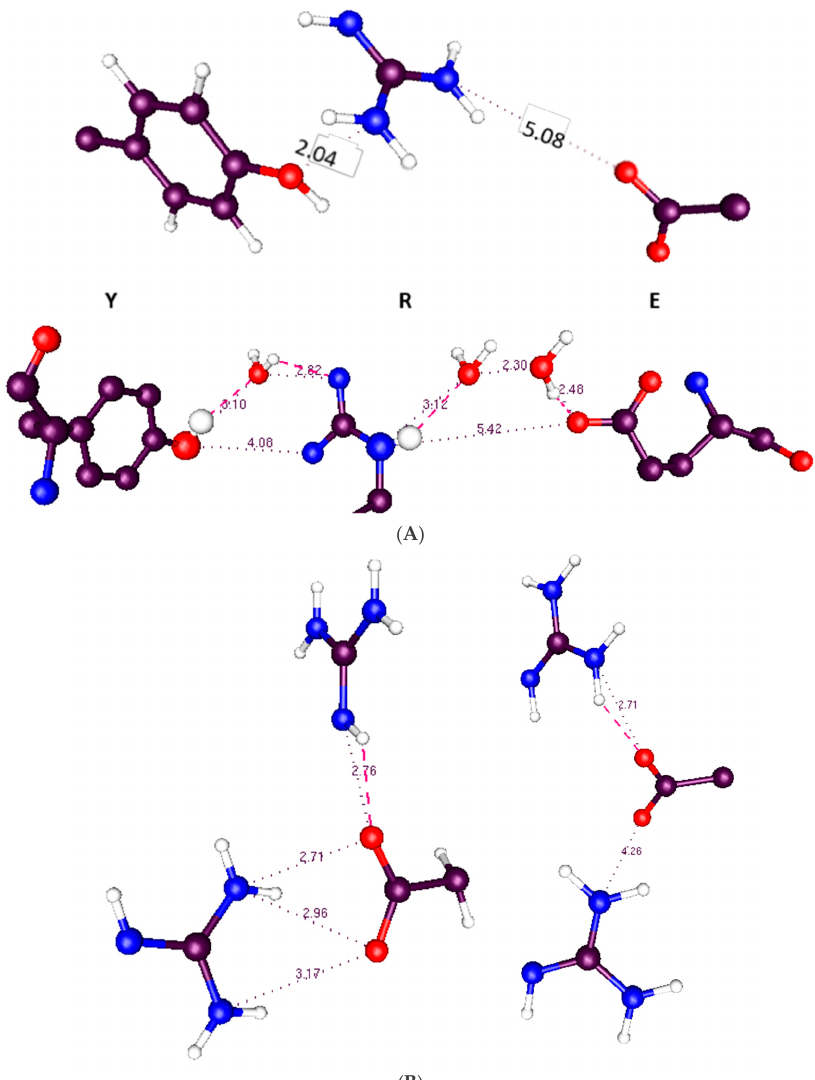
Figure 5. ( A ) Comparison of VSD (top) and bacteriorhodopsin (bottom) triads of tyrosine, arginine, and glutamate; both are from the X-ray structures, not computation. Some interatomic distances are shown, and are very similar; e.g., the arginine nitrogen to glutamate oxygen: 5.08 (VSD) vs. 5.42 (BR). Three water molecules are present in the bacteriorhodopsin structure, with one very short distance (2.30 Å) between water oxygens (oxygens are from the X-ray structure, hydrogens added), and only parts of side chains are shown. The distances are similar, especially from the arginine nitrogen to glutamate, which is the same within experimental error. It is not difficult to see a proton path across the triads. Tyrosine, arginine and glutamate are on the VSD: Y415, R419, E136; on bacteriorhodopsin (pdb: 1P8H) Y57, R82, E194. This illustrates that there are several triads, as this is not the triad discussed earlier, but a different set on the path to the gate. The orientations are not identical, and the water in the bacteriorhodopsin makes up the difference; ( B ) A second triad, comparing K v 1.2 to H v 1, this one RER/RDR instead of YRE. Left: H v 1: R201 (top), D108, R204 (pdb:3WKV); right the VSD of the K v 1.2 channel (3Lut); R300 (top), E226, R303. H v 1 uses the NE nitrogen of R201 (top). As in ( A ), the distances of the triads are very similar. The use of the arginine NE by H v 1 is an example of the use of the amphoteric property of this side chain to transmit a